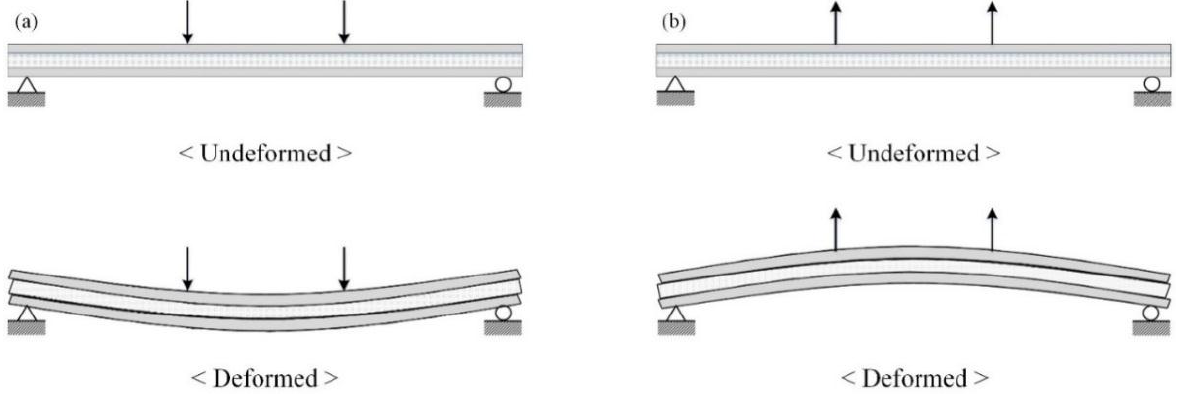
Figure 4. Diagram of the structural behavior of ICSWP specimens under ( a ) positive load (wind pressure) and ( b ) negative load (wind